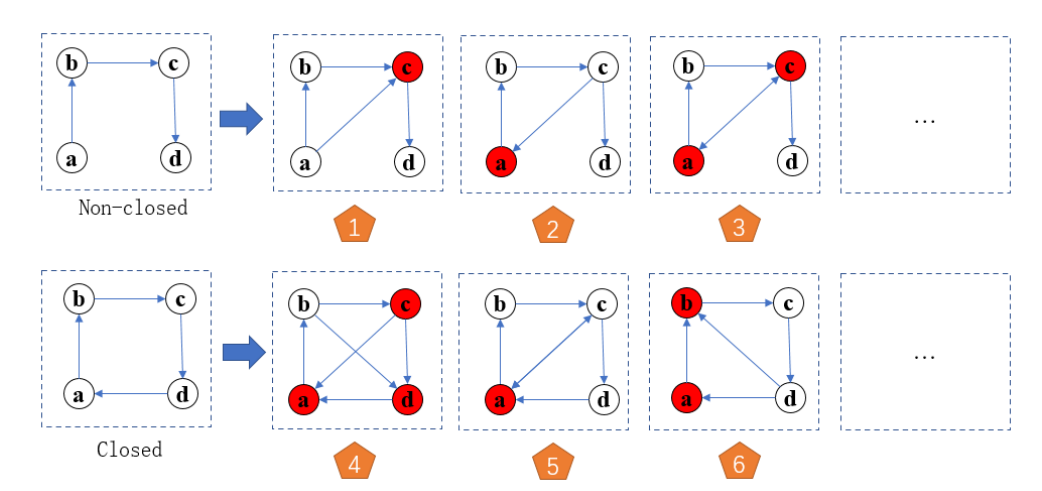
Figure 4. Diagram of motif evolution.